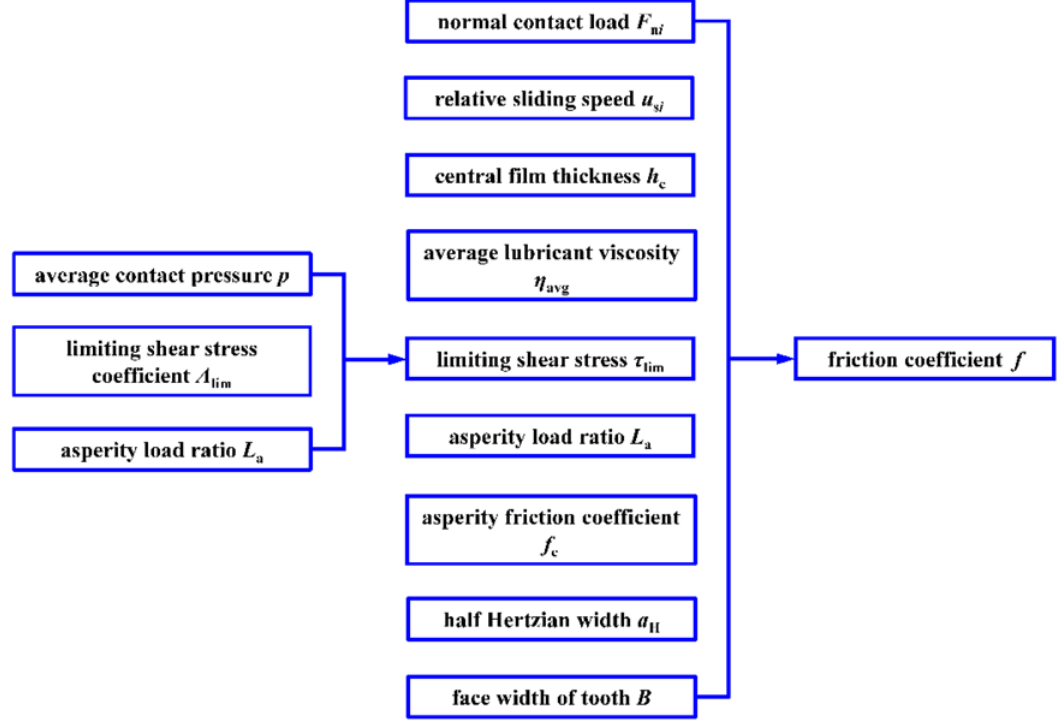
Fig. 5. Calculation procedure of friction coef fi